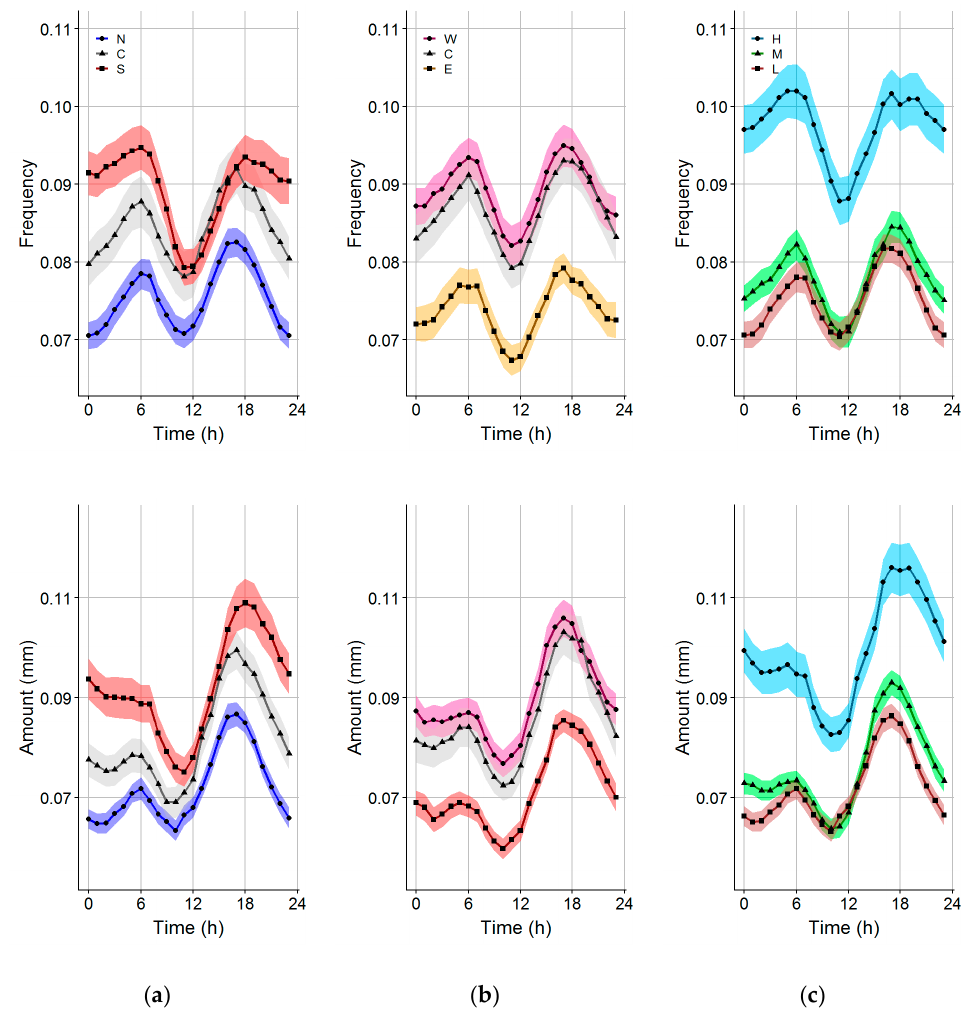
Figure 2. Precipitation diurnal cycles (PDC) represented by the long-term averages of the hourly precipitation occurrence frequency ( upper panel ) and the long-term averages of the hourly precipitation amount ( lower panel ) with shaded 95% confidence intervals in different ( a ) latitudes, ( b ) longitudes, and ( c ) elevations (see Table 1 for the definitions of the classes; N—north, C—central, and S—south ( a ); W—west, C—central, and E—east ( b ); and H—high, M—medium, and L—low ( c )).